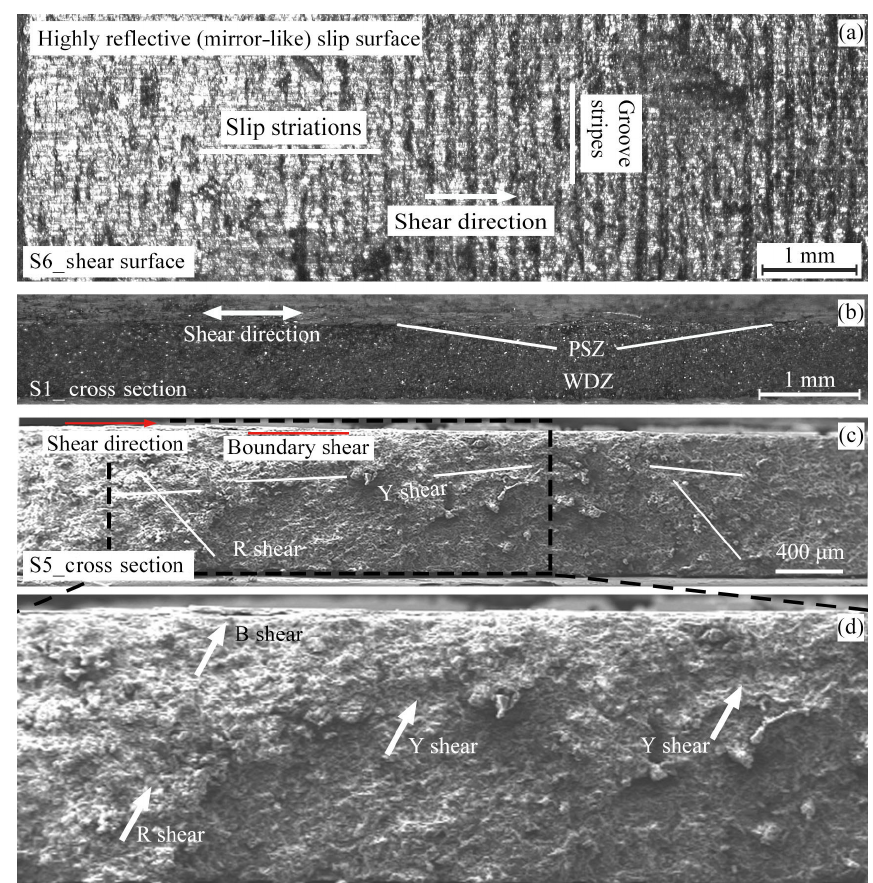
Figure 6. Microstructure of samples S1, S5 and S6 after shear deformation. Panels (a) and (b) were imaged using an optical microscope in a reflected light mode, while (c) was imaged using an SEM in secondary electron mode. (a) The shear surface of sample S6, showing a highly reflective (mirror-like) slip surface on the left-hand side of the image (below the corresponding label). (b) The cross section of sample S1 in an orientation parallel to the shear direction, indicating a principal slip zone (PSZ) and a weakly deformed zone (WDZ). (c) The cross section of sample S5 in an orientation parallel to the shear direction, showing the development of R-shear, boundary and Y-shear bands. (d) The magnification of the region marked in (c)